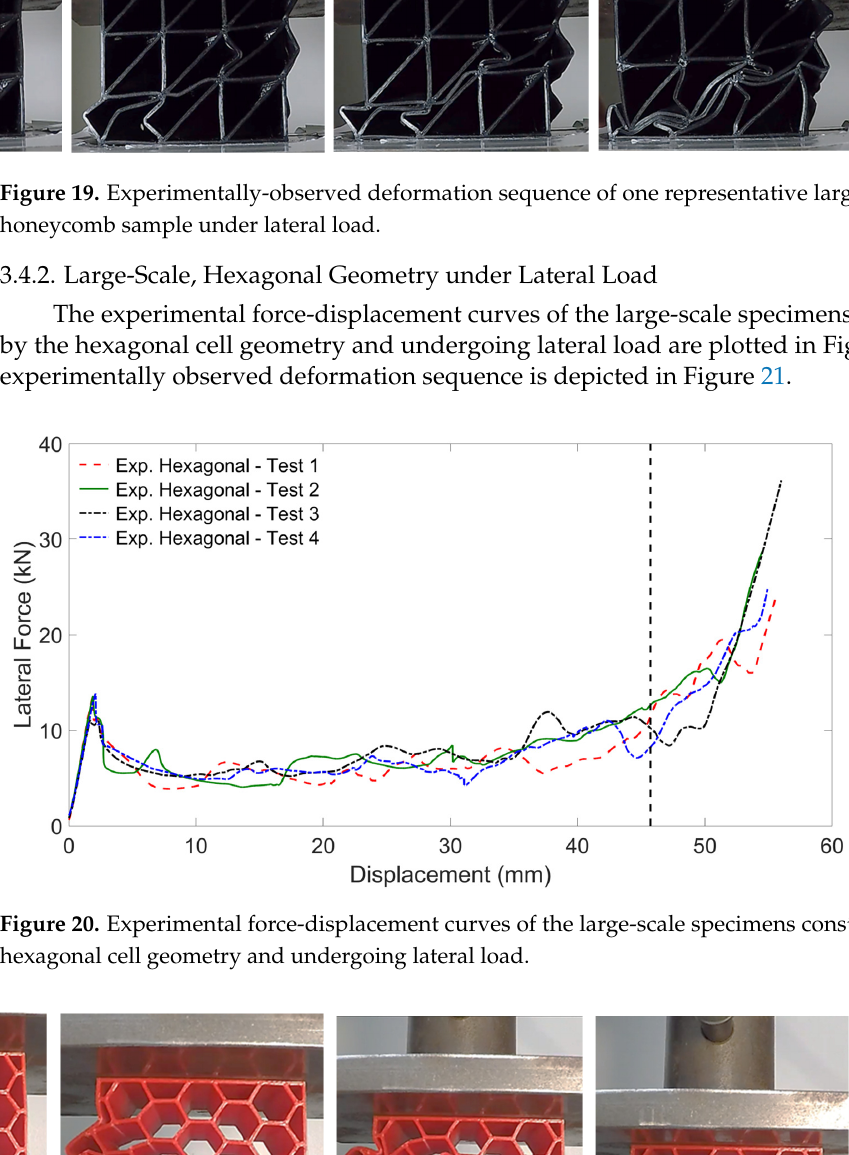
Figure 21. Experimentally-observed deformation sequence of one representative large-scale hexagonal honeycomb sample under lateral load.